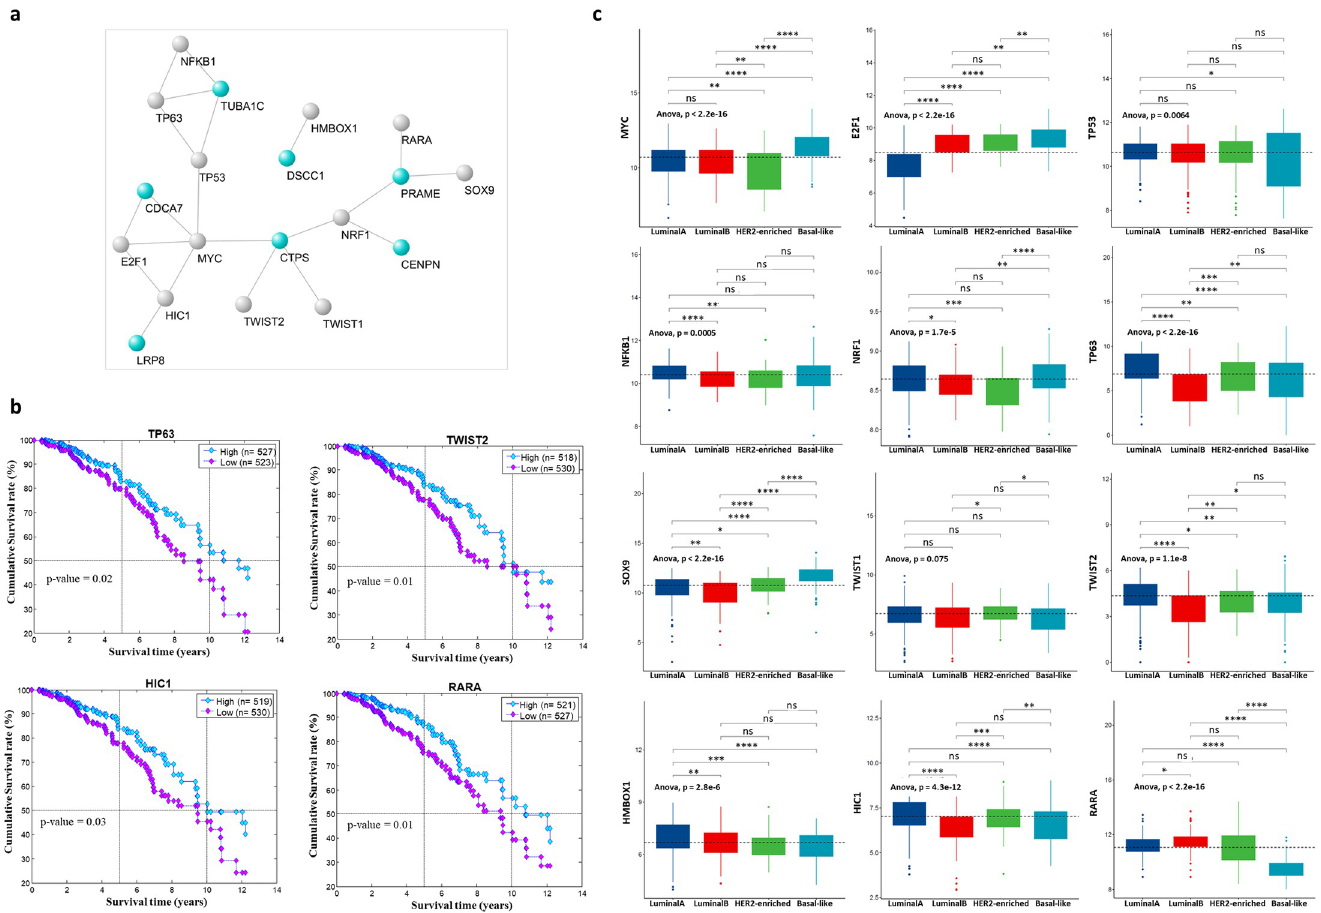
Fig 6. Gene regulatory network of the basal-like prognostic biomarkers. a) Network of the regulatory interactions among the identified switch genes and the known transcription factors (TFs). Light blue nodes represent switch genes; grey nodes represent transcription factors. b) TFs with a statistically significant prognostic value according to the Kaplan-Meier survival analysis. Kaplan-Meier analyzes to evaluate the correlations between the expression of the TFs and the OS in TCGA breast invasive carcinoma patients. Low- and high-expression groups refer to patients with expression levels lower and greater than the 50th percentile, respectively. c) Expression of the TFs in the gene regulatory network across the PAM50 breast cancer subtypes. The black dashed line reported in each plot indicates the median value used in the Kaplan-Meier survival analysis to split the low-expression and high-expression group. One-way ANOVA test was used to compare the means of the selected genes among the patients’ groups. T-test was used to perform multiple pairwise-comparisons and statistical significance was indicated by the star symbols (i.e., ns: p > 0.05, � : p � 0.05, �� : p � 0.01, ��� : p � 0.001, ���� : p � 0.0001).